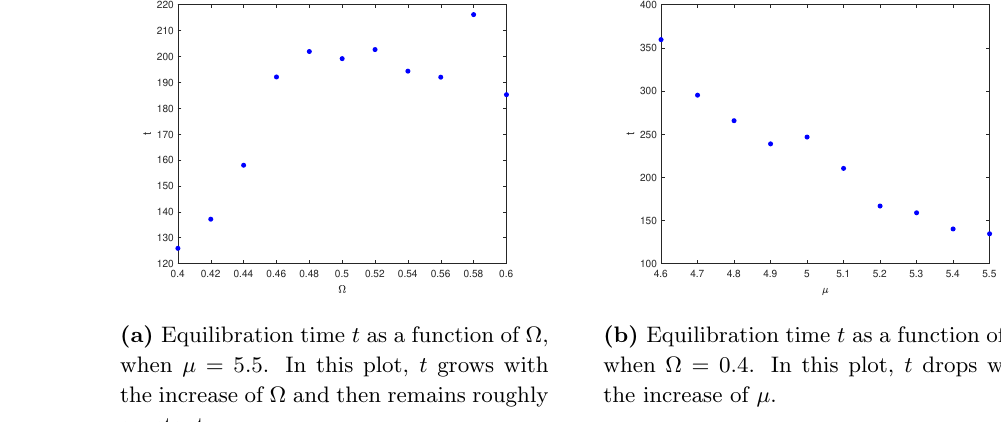
Figure 10. The equilibration time with R = 6.